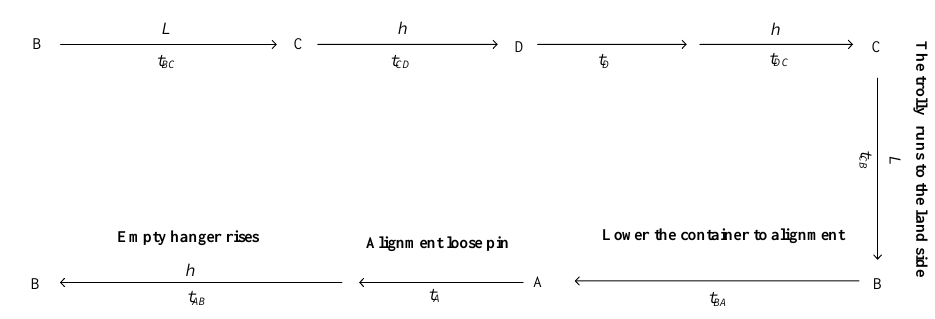
Figure 2. Periodicity of quay cranes ’ operation process.